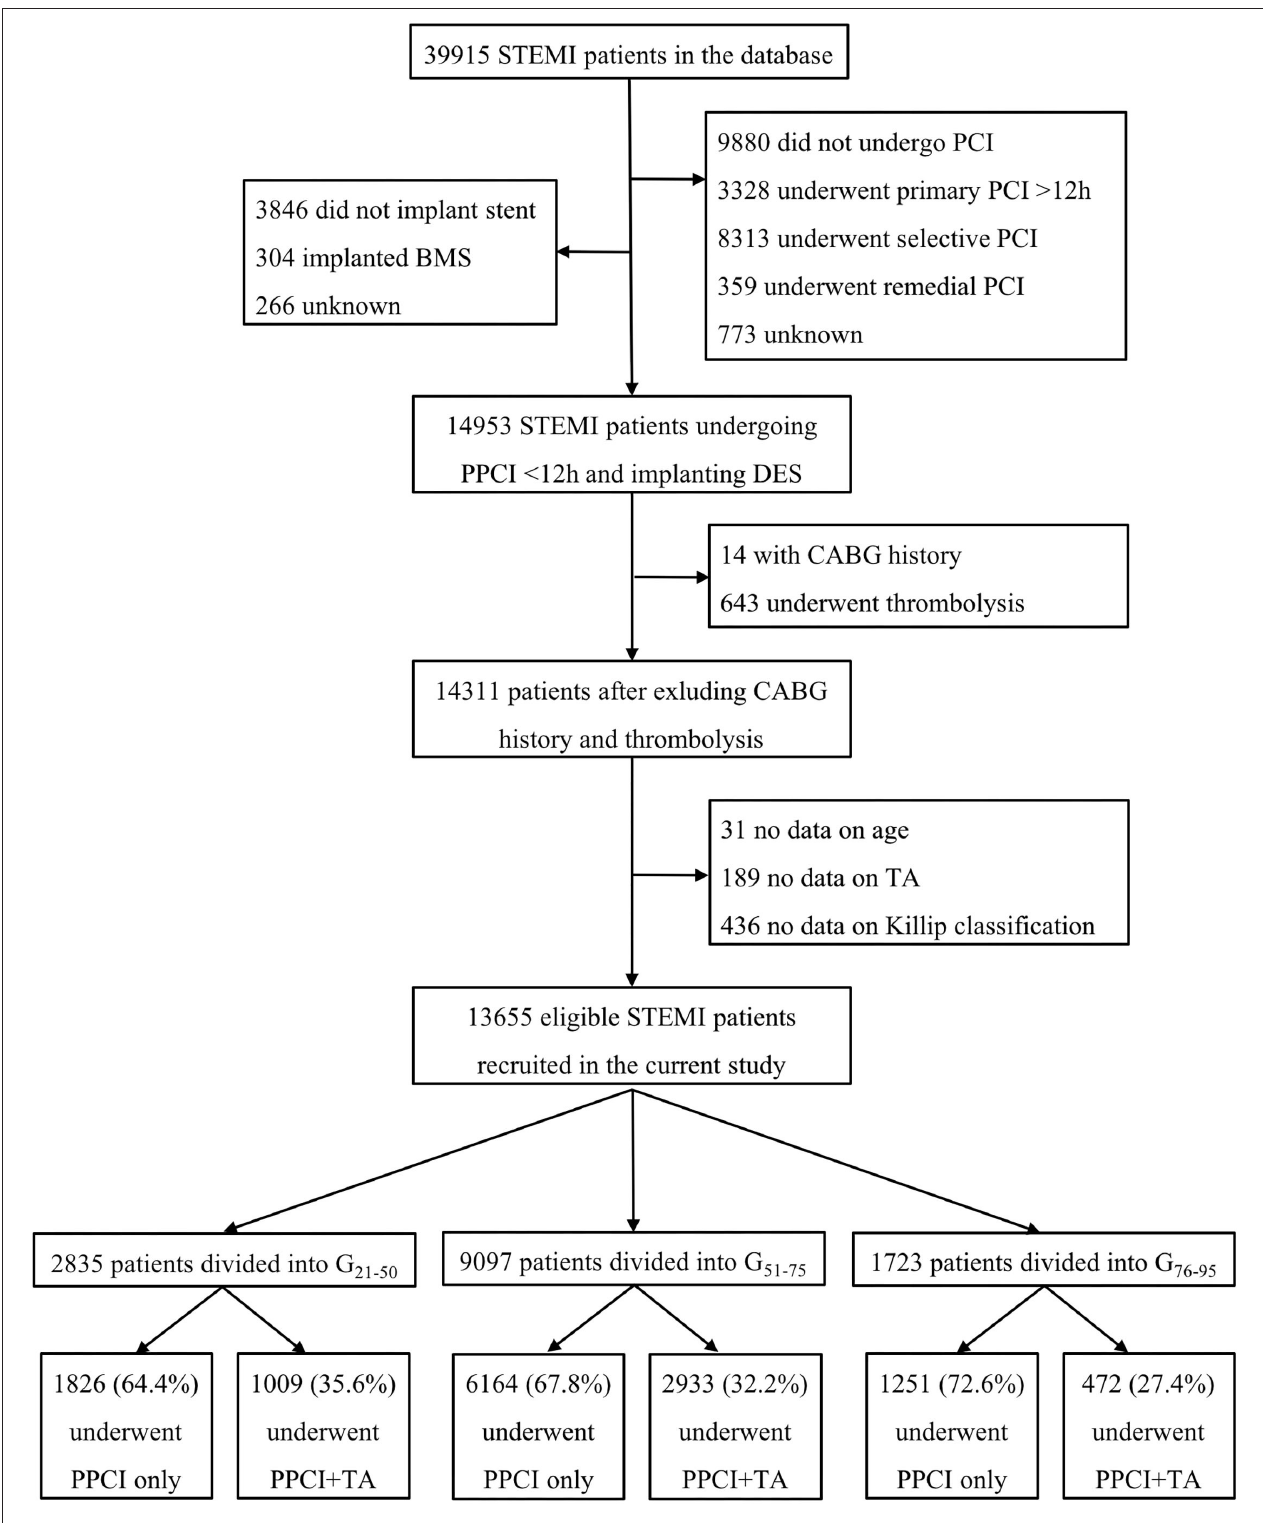
FIGURE 1 | Study flowchart. STEMI, ST-segment elevation myocardial infarction; PCI, percutaneous coronary intervention; PPCI, primary percutaneous coronary intervention; BMS, bare metal stent; DES, drug-eluting stent; CABG, coronary artery bypass grafting; TA, thrombus aspiration.